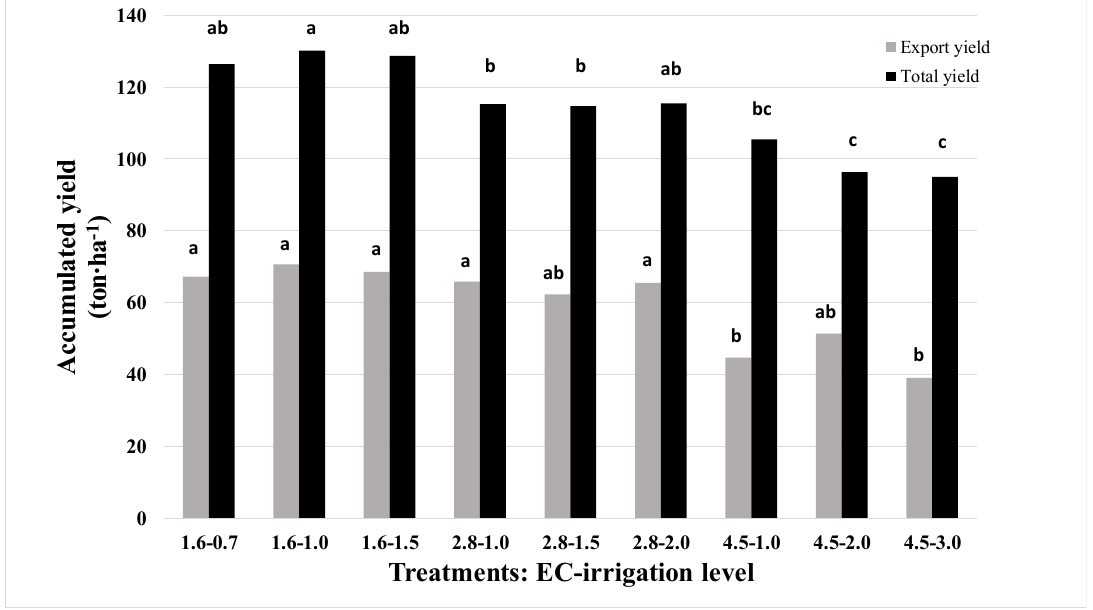
Figure 1. The influence of water quality (electrical conductivity (EC) of the irrigation—1.6, 2.8 and 4.5 dS m − 1 EC) and water quantity on the cumulative total and export-quality yields of pepper between December and mid-March. Means of columns with the same letter are not significantly different (LSD; p < 0.05).